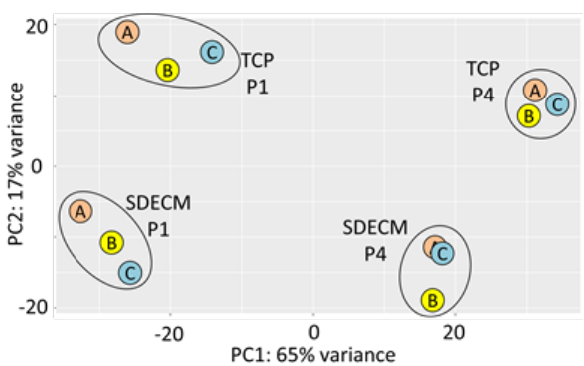
Figure 2. Principal component analysis. Samples are clearly clustered by their passage (P) in principal component (PC) PC1 and surface in PC2; donors are indicated by the letter within the circle (A, B, C).